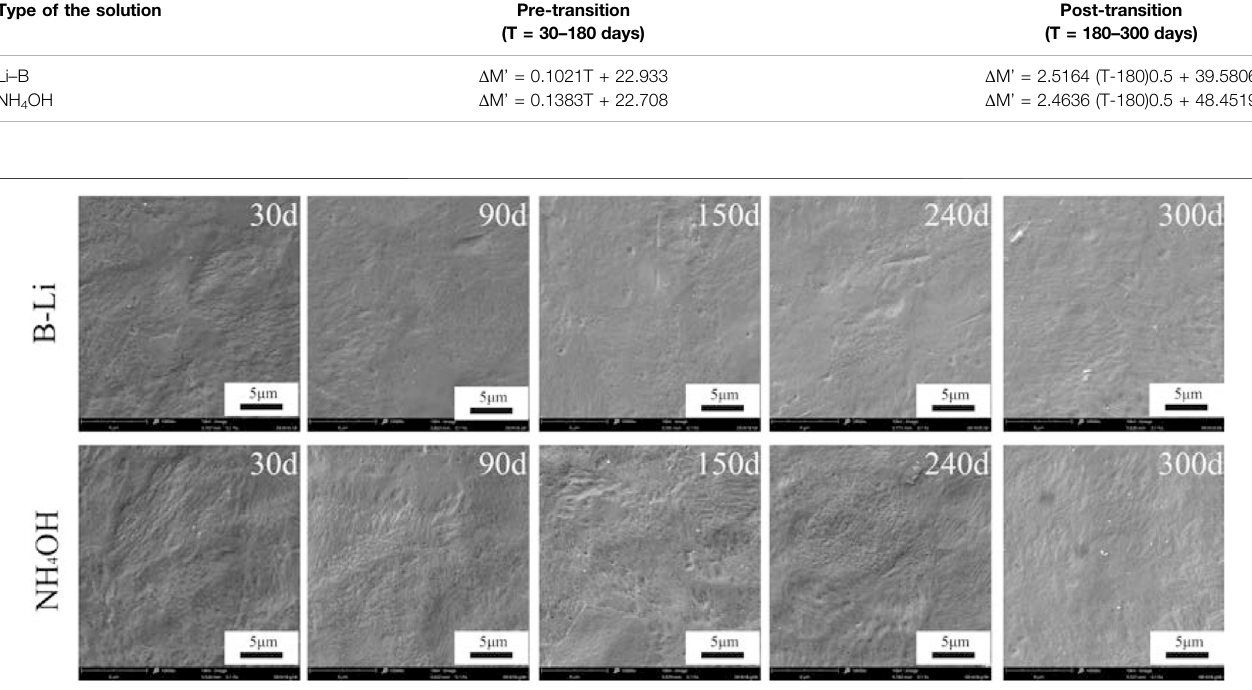
FIGURE 2 | SEM images of the surface morphologies of the oxidation fi lms.